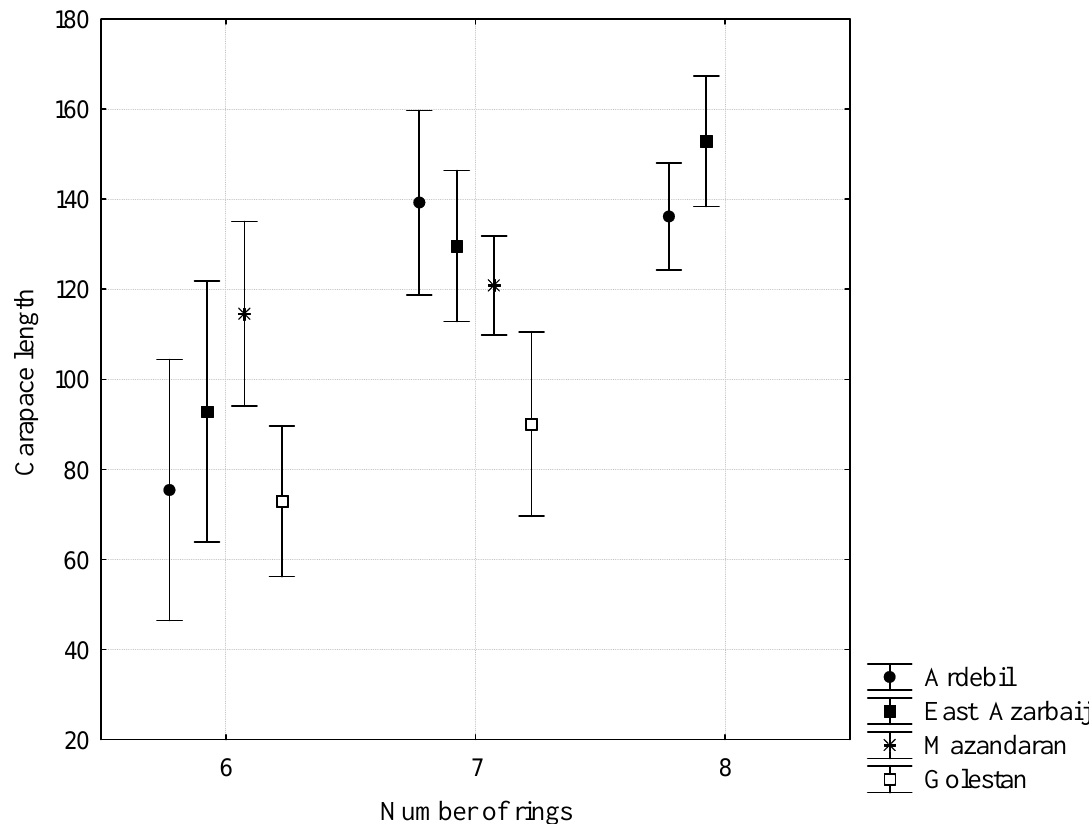
F IGURE 2. Carapace lengths vs. age group estimated by number of rings on carapace of turtle from four